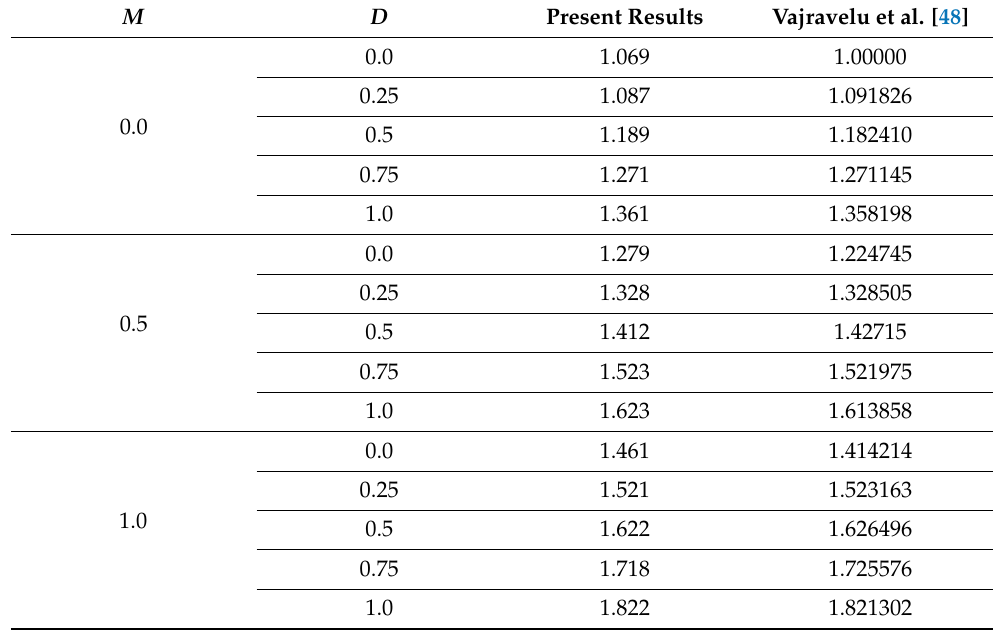
Table 2. Comparison of the skin friction coefficient with Vajravelu et al. [48] for different values of magnetic field parameter and curvature parameter when φ = A = β = Nr = Ec = S = B = 0, Q = = 1. b = λ = κ f = κ ∗ mf